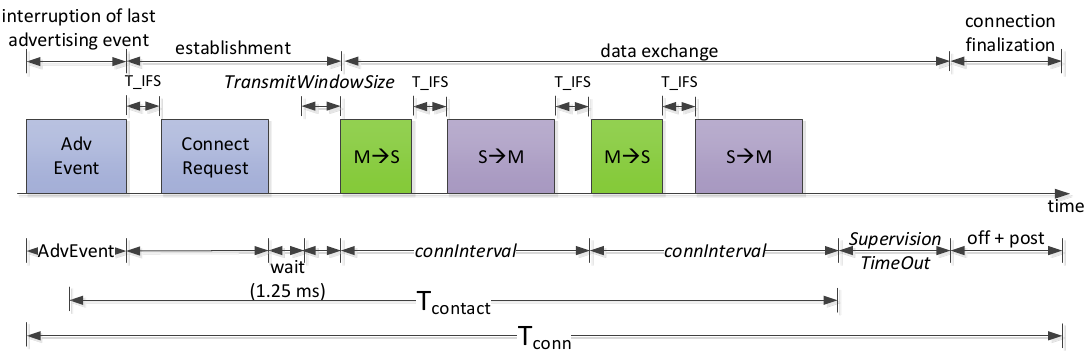
Figure 8. Illustration of the components related with connection establishment, use and finalization.